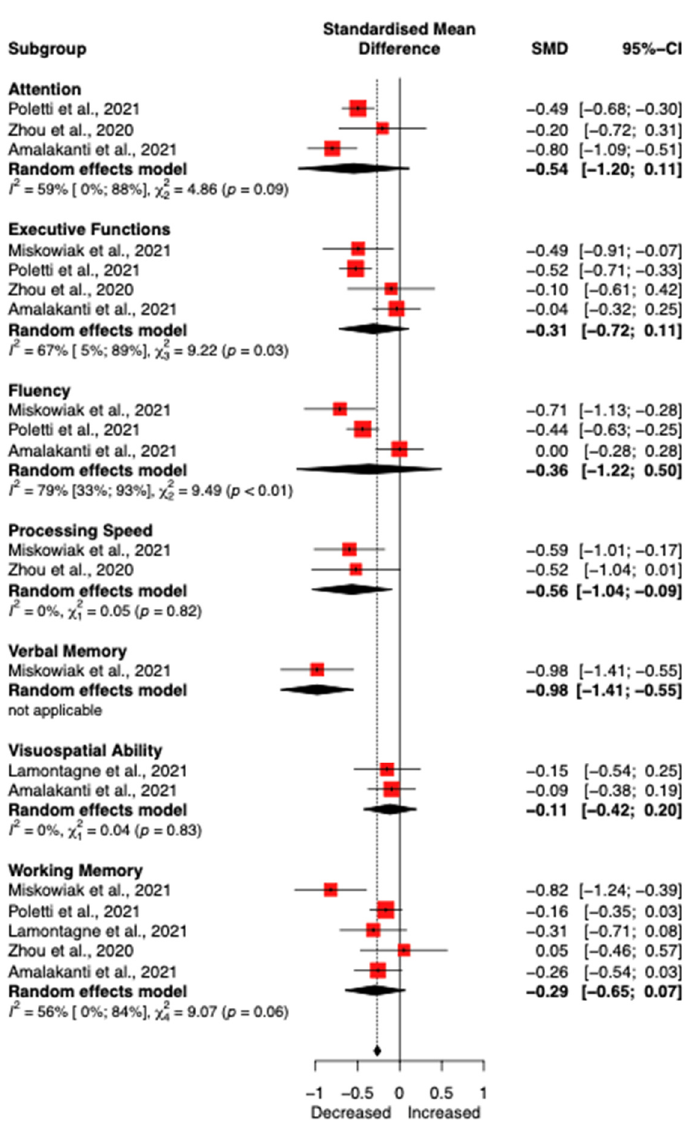
Figure 2. Stratified meta-analysis according to cognitive sub-functions. Results are indicated with 95% confidence intervals. Negative Standardized Mean Difference (SMD) indicates a decrease in cognitive functions in COVID-19 patients compared to healthy individuals [22,24,31,34,37].